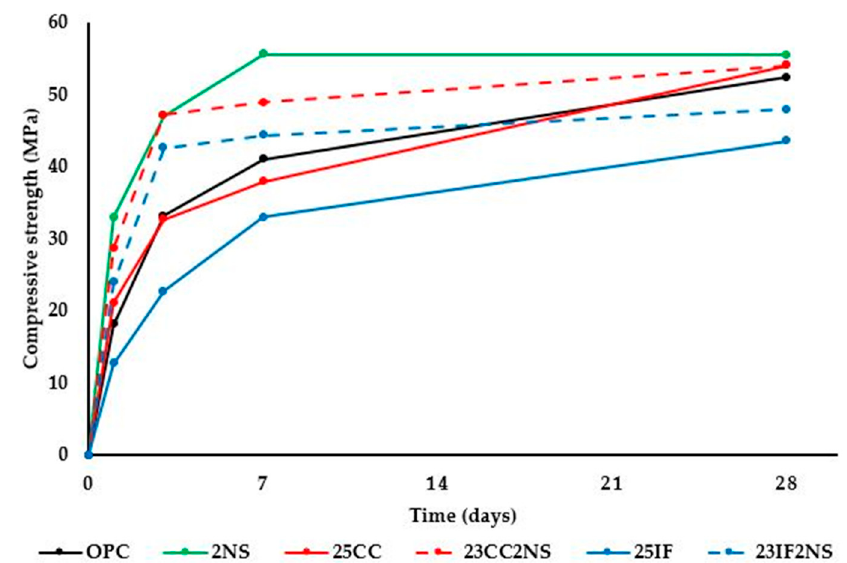
Figure 9. Compressive strength of pastes during hydration up to 28 days.